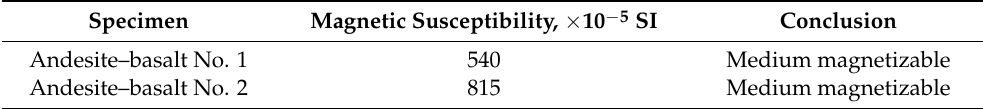
Table 6. Magnetic properties of igneous rocks at the Gyulagarak observatory location.